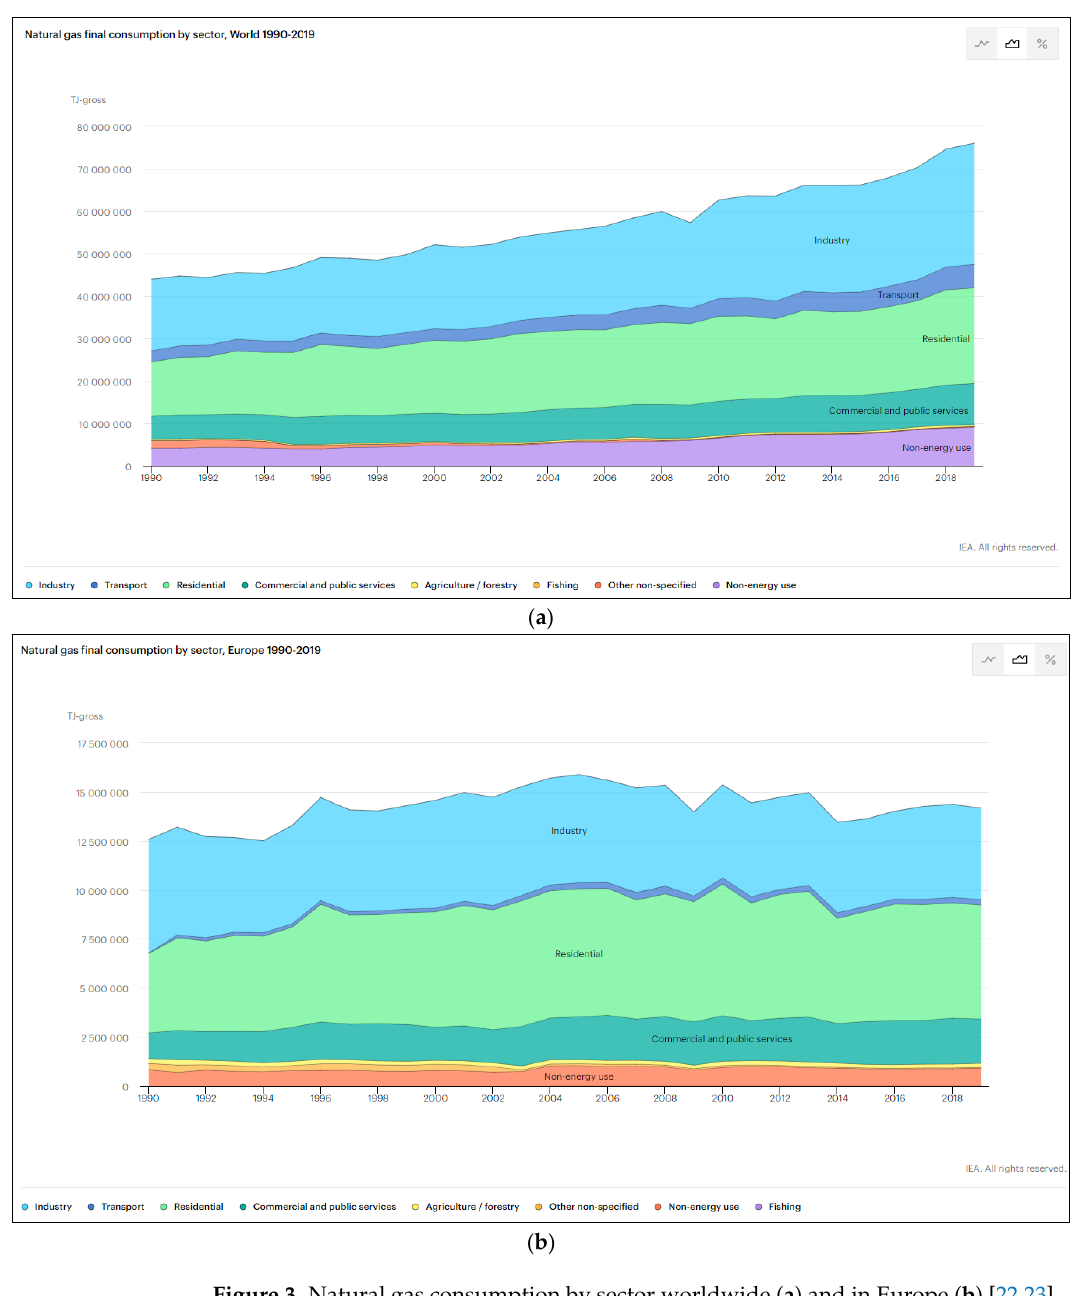
Figure 3. Natural gas consumption by sector worldwide ( a ) and in Europe ( b ) [22,23]. European countries extensively rely on external countries for NG supply. For instance, in 2021 the EU imported up to 80% of its total required gas needs and the ongoing situation is getting worse as domestic production fell 50% in the last 10 years. Of the demand, 40% is consumed by the residential sector followed by industry and gas use for power generation. However, because of the combined effect of both the ongoing deindus- trialization process in Europe and the increase in process energy efficiency, industry con- sumption has declined by 20% since 2000 [24]. Electrification of the economy is increasing the electrical demand and, despite the increase in Renewable Energy generation, in the